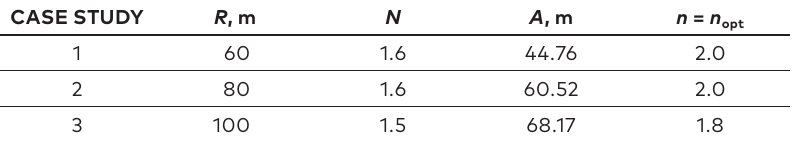
Table 5. Design hyperclothoids: scale factor A and shape factor n CASE